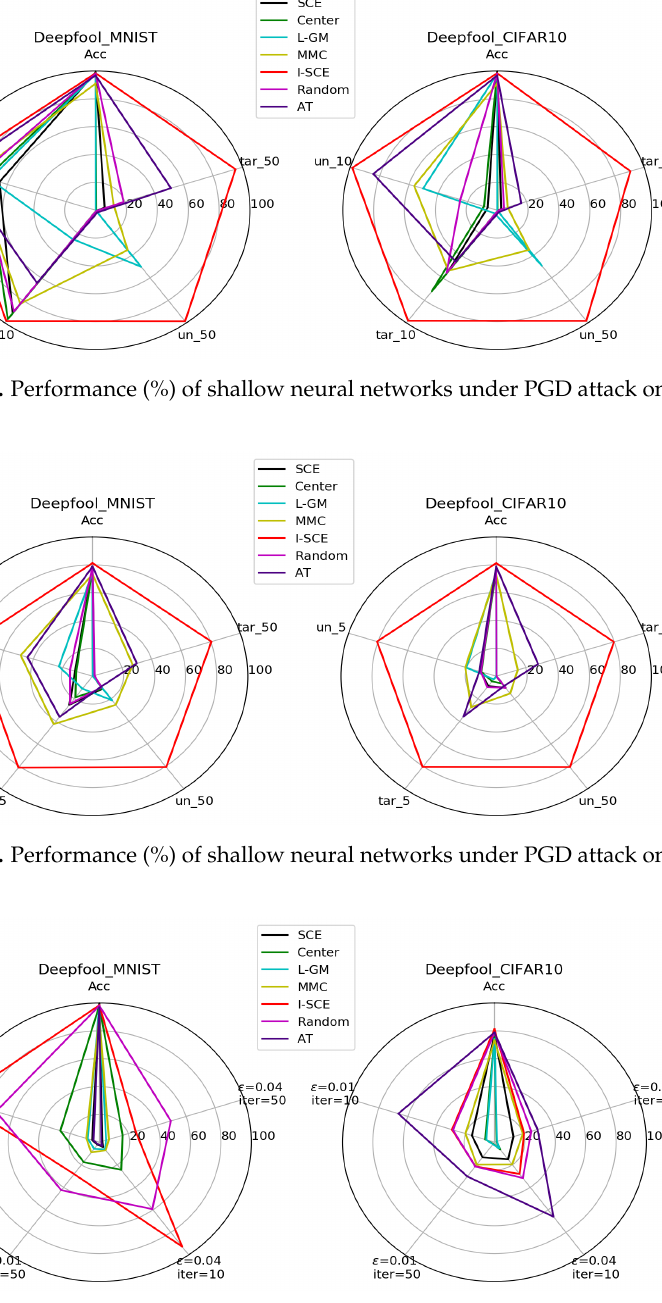
Figure 12. Performance (%) of shallow neural networks under Deepfool